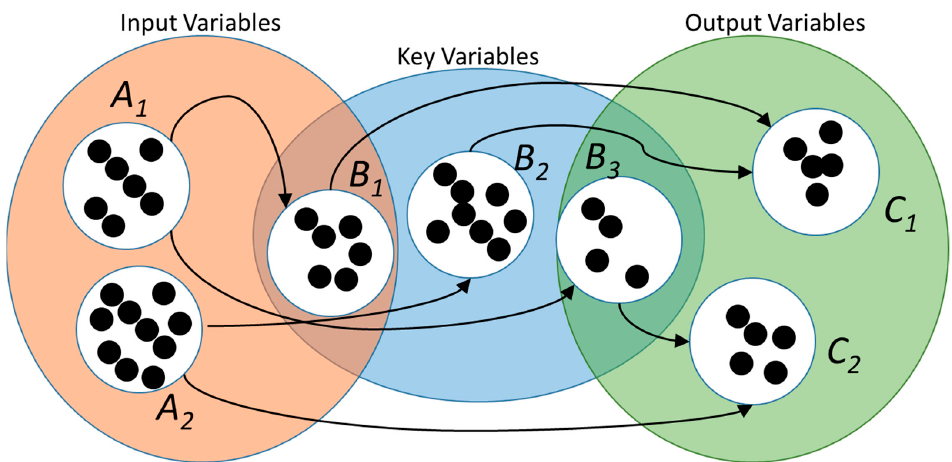
Figure 3. The current meta modelling consideration.